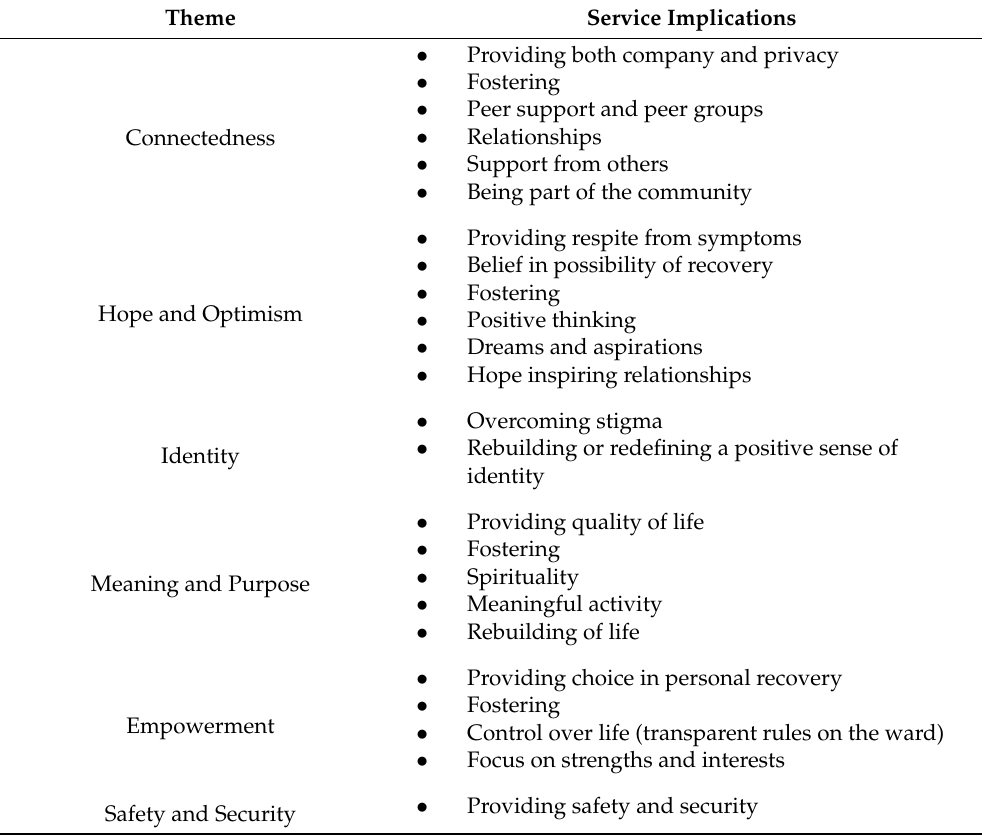
Table 1. CHIMES model of recovery and